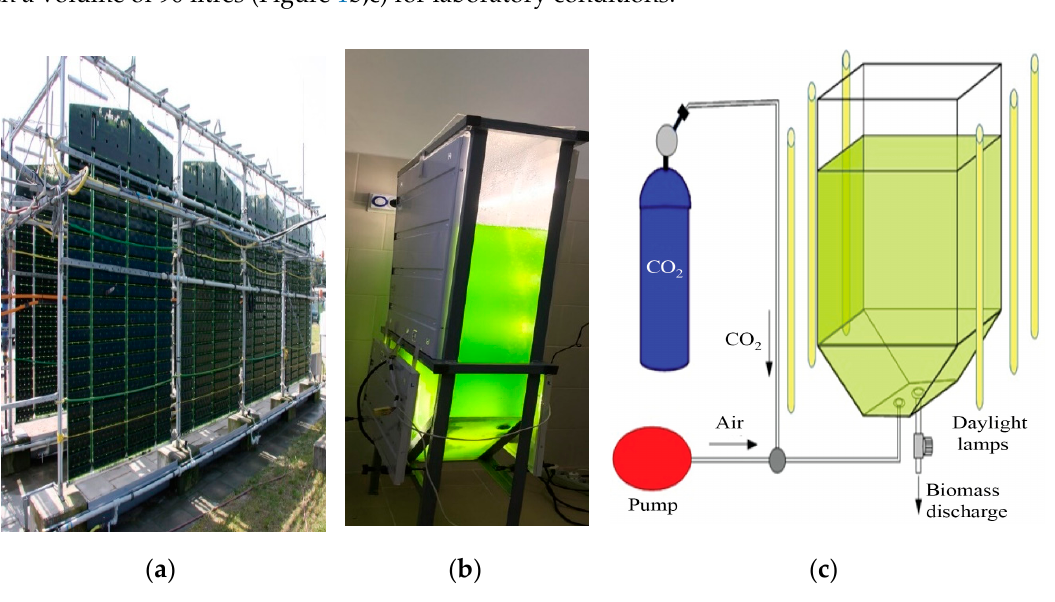
Figure 1. Closed photobioreactors for C. Sorokiniana microalgae biomass cultivation: ( a ) for cultivation under natural conditions, ( b ) for cultivation under laboratory conditions, ( c ) photobioreactor scheme.